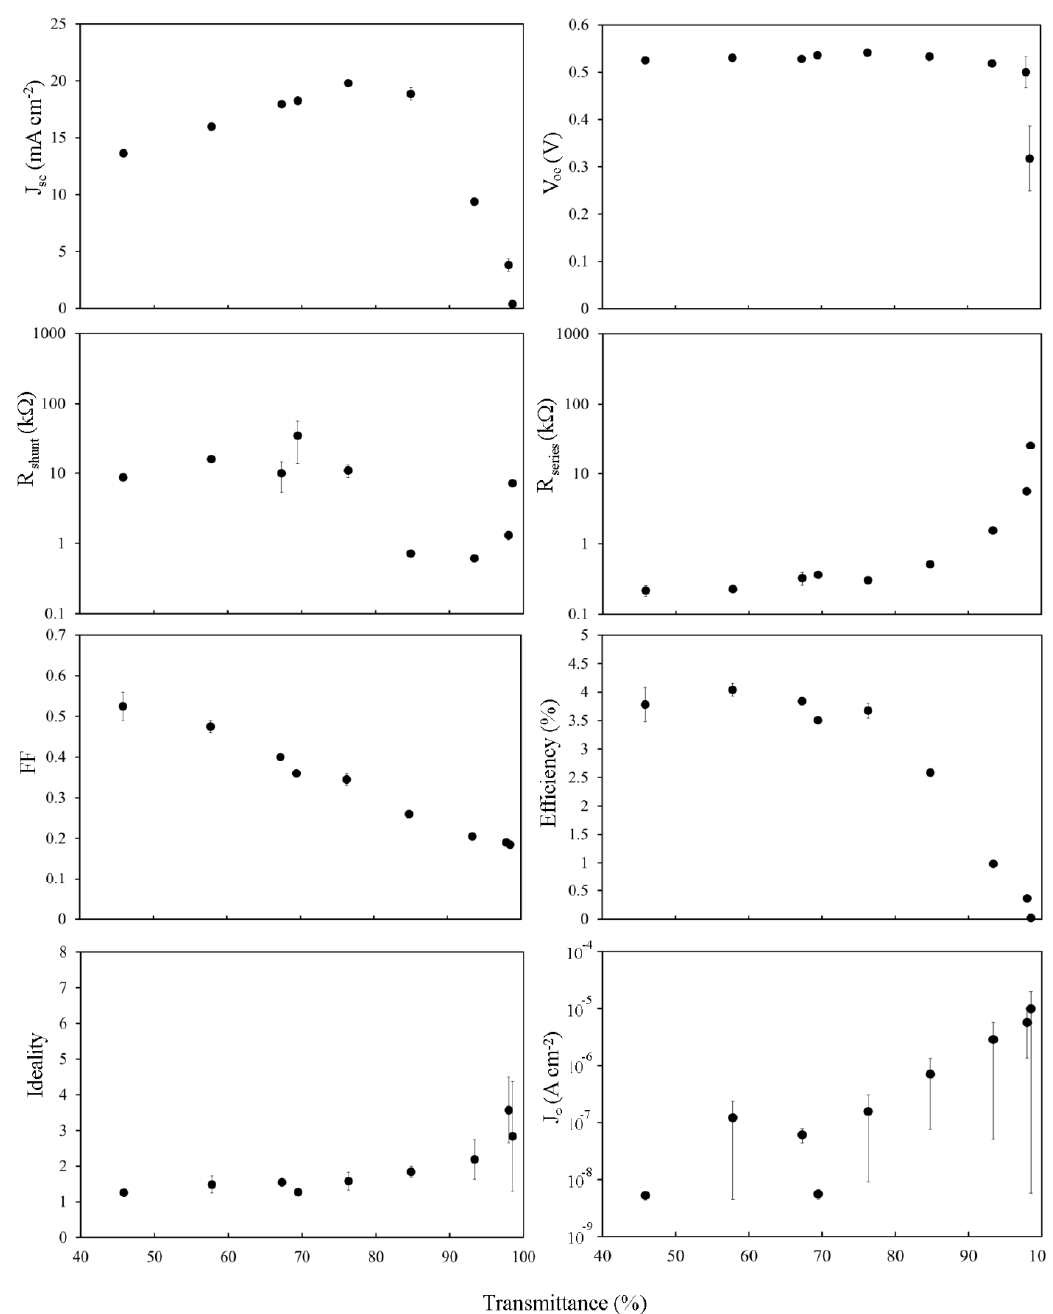
Figure 6. Solar cell parameters extracted from SOCl varying SWCNT film